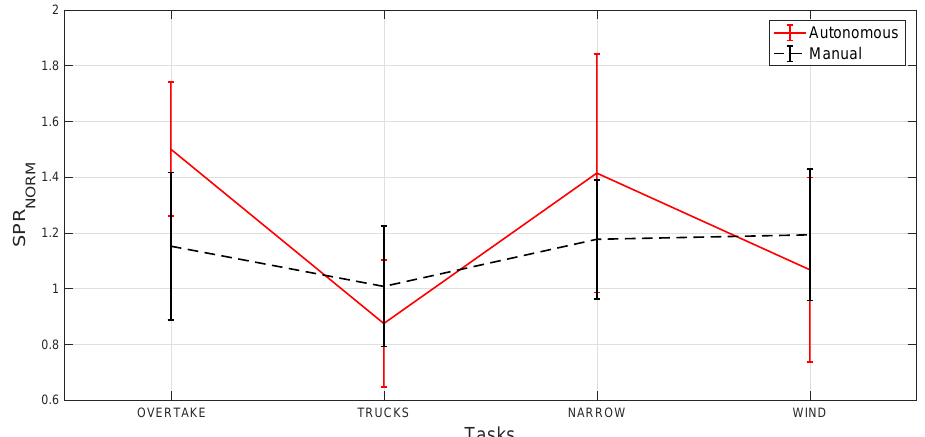
Figure 7. Normalized SPR over the tasks for autonomous (red line) and manual (black line). Error bars represent the standard deviation among the